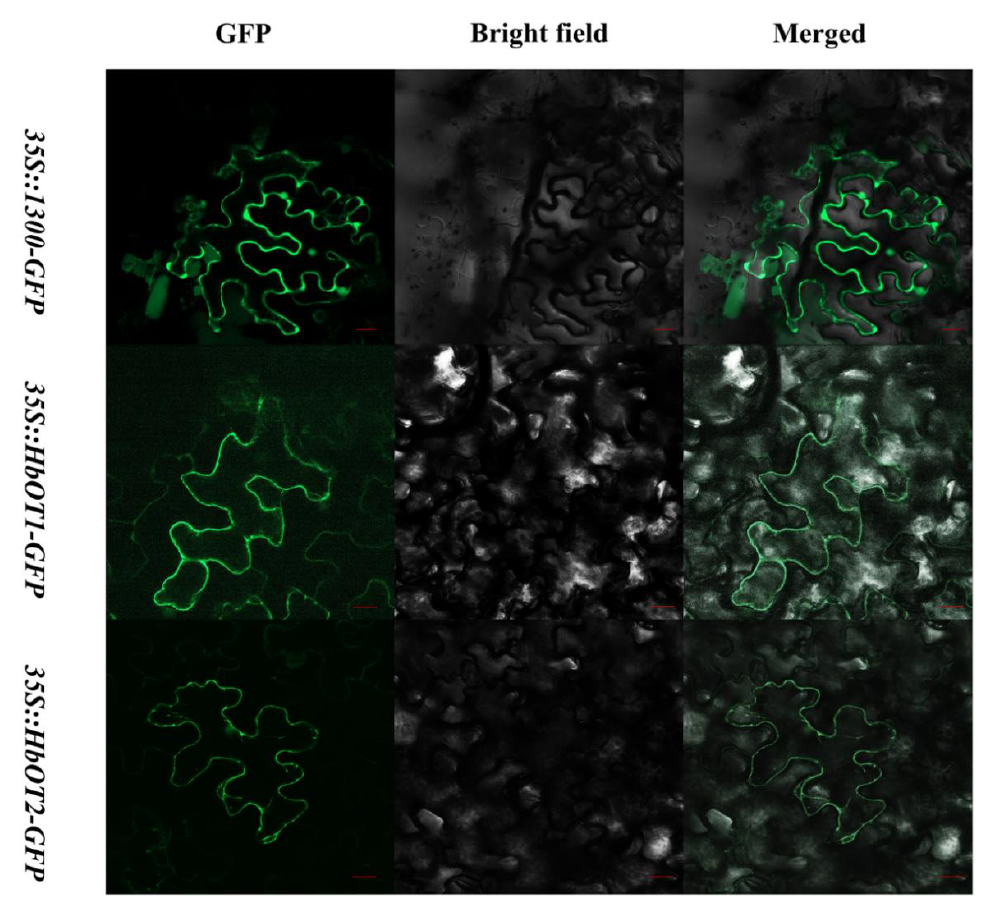
Figure 3. Subcellular localization of HbOT1 and HbOT2 . The 35S::HbOT1-GFP and 35S::HbOT2-GFP fusion proteins were transiently expressed in tobacco ( N. benthamiana ) leaf epidermal cells. Bars indicate the length of 20 um.